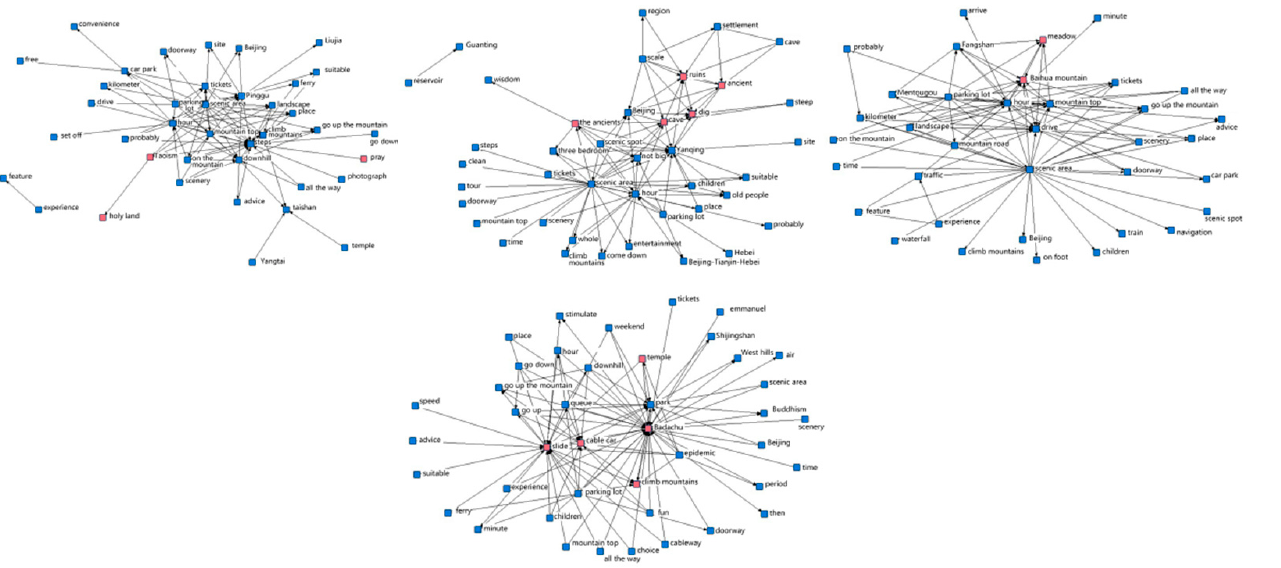
Figure 19. The semantic web of mountain landscapes in various administrative regions (From left to right: Pinggu District, Yanqing District, Mentougou District, and Shijingshan District).